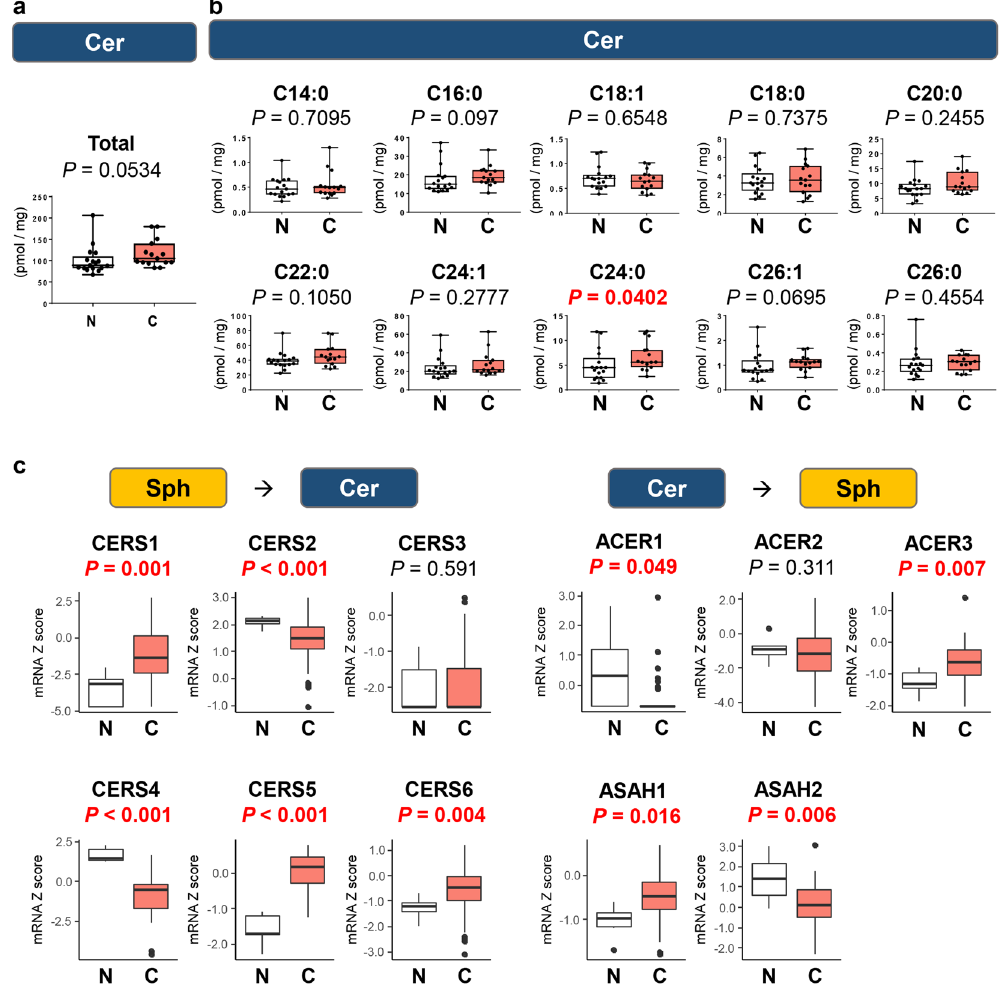
Figure 2. Ceramide is not increased in biliary tract cancer compared to normal biliary tract tissue. The levels of total ceramide ( a ) and each ceramide species (C14:0, C16:0, C18:1, C18:0, C20:0, C22:0, C24:1, C24:0, C26:1, and C26:0) ( b ) in biliary tract cancer (n = 15) and normal biliary tract tissue (n = 17) were determined by LC-ESI-MS/MS. ( c ) The gene expression levels of CERS1, CERS2, CERS3, CERS4, CERS5, CERS6, ACER1, ACER2, ACER3, ASAH1 and ASAH2 in TCGA cohort (36 and 9 samples of cancer and non-cancer tissue in cholangiocarcinoma cohort) were analyzed. Mean values are shown by the horizontal lines. Two-sided P values < 0.05 were considered statistically significant (Mann-Whitney U test). N: normal biliary tract tissue; C: biliary tract cancer